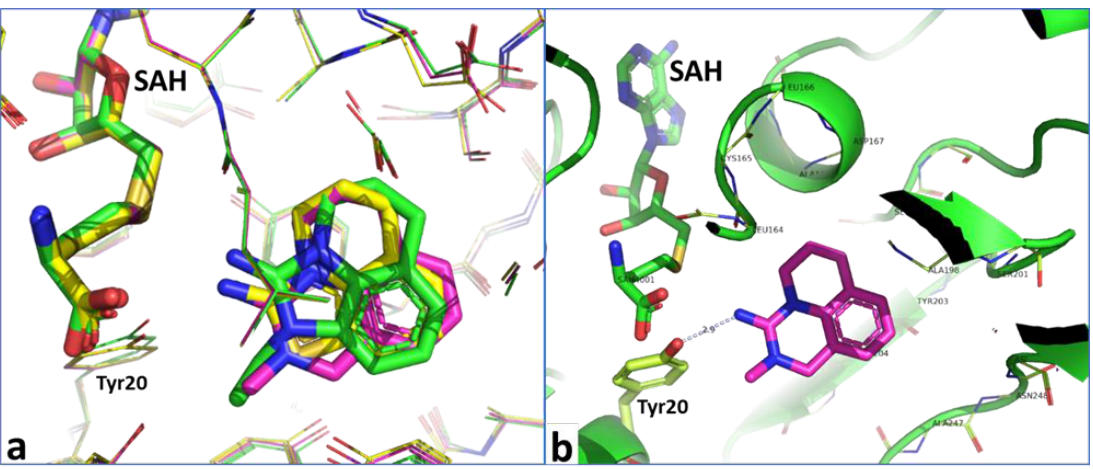
Figure 11. ( a ) Superposition of the crystal structures of the three Nam analogs ( 2 ) (yellow), ( 3 ) (green) and ( 4 ) (magenta). The binding mode of the three inhibitors is very similar. ( b ) Crystal structure showing the binding mode of ( 4 ) in hNNMT.